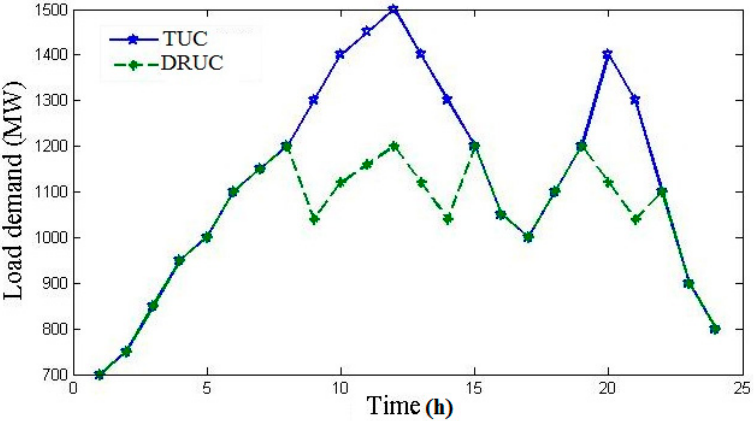
Figure 6. Load demand vs. time curve for TUC and DRUC.